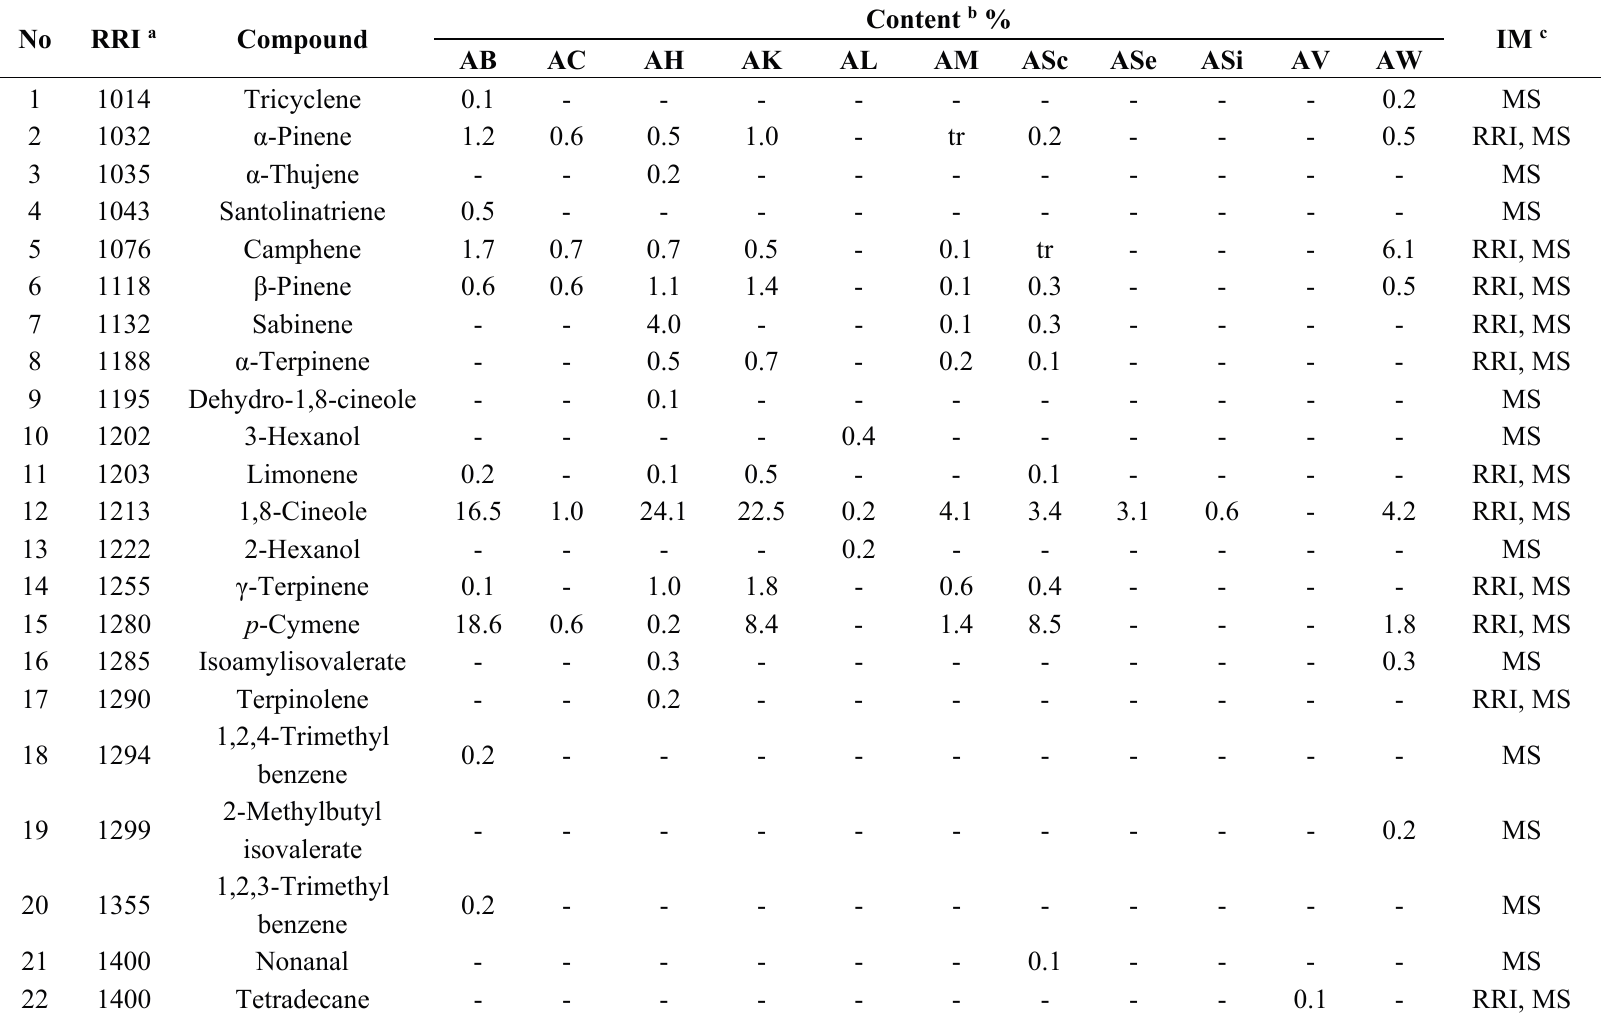
Table 1. The composition of the essential oils of Achillea species. AB: A. biebersteinii , AC: A. coarctata , AH: A. hamzaoglui , AK: A. kotschyi subsp. kotschyi , AL: A. lycaonica , AM: A. millefolium subsp. millefolium , ASc: A. schischkinii , ASe: A. setacea , ASi: A. sintenisii , AV: A. vermicularis , and AW: A. wilhelmsii subsp.